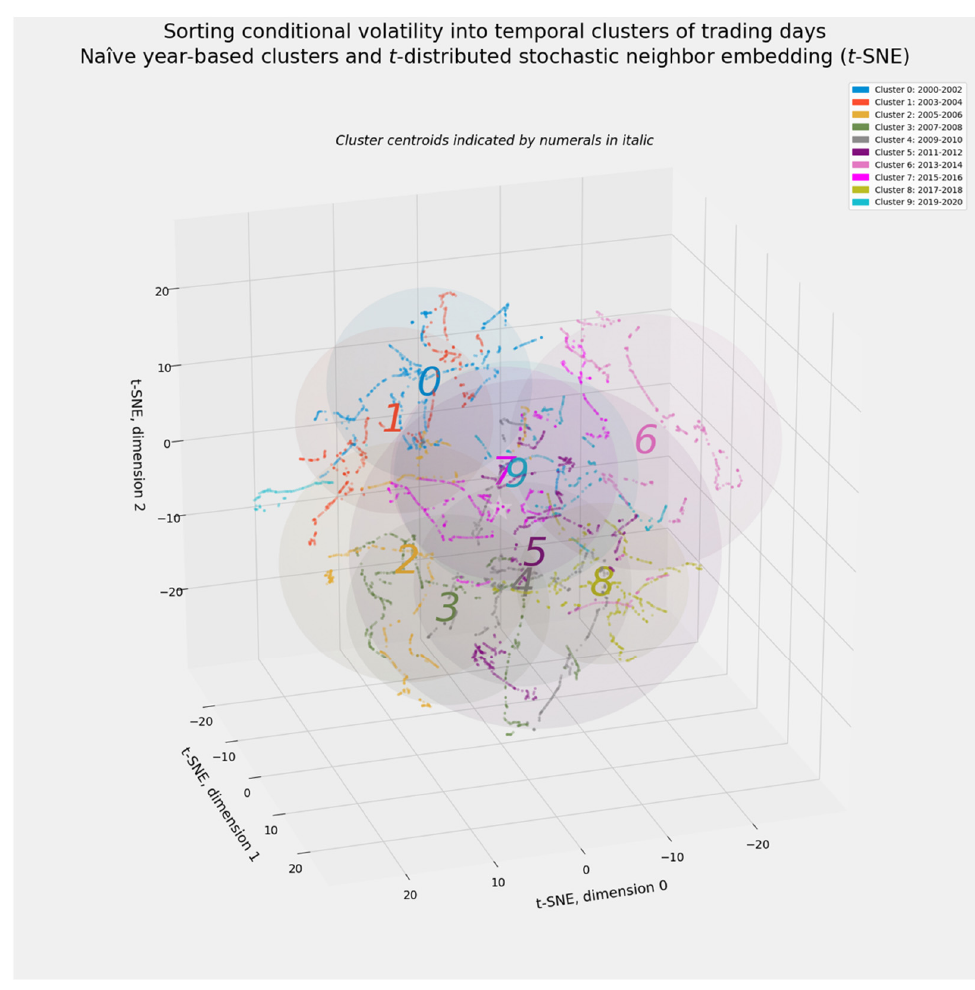
Figure 5. Naïve, biennially defined clusters in commodity markets—with spheres representing the mean distance of each cluster’s observations from its synthetic centroid.